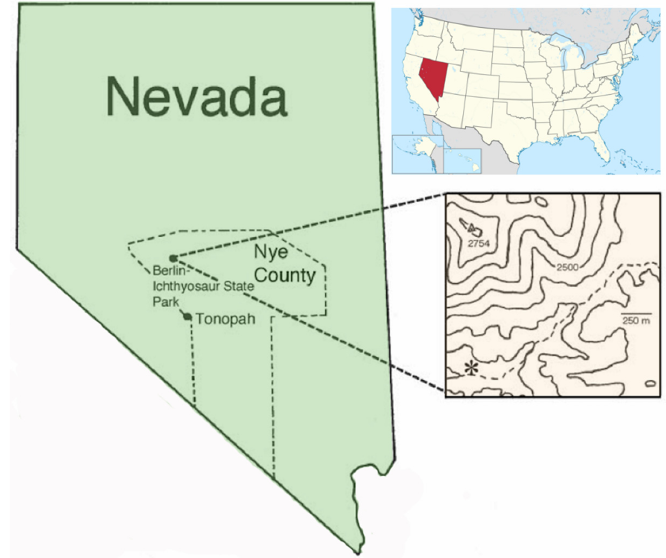
Figure 1. Field locality map, Union Canyon, Shoshone Range, Nevada. The asterisk on the inset map denotes the nuculanoid fossil bivalve locality. The dashed line on the inset map is the West Union Canyon jeep trail (National Forest District Road 24), and the 2754 m peak is Buffalo Mountain. The inset map in the upper right shows the position of Nevada (red) in the continental United States.